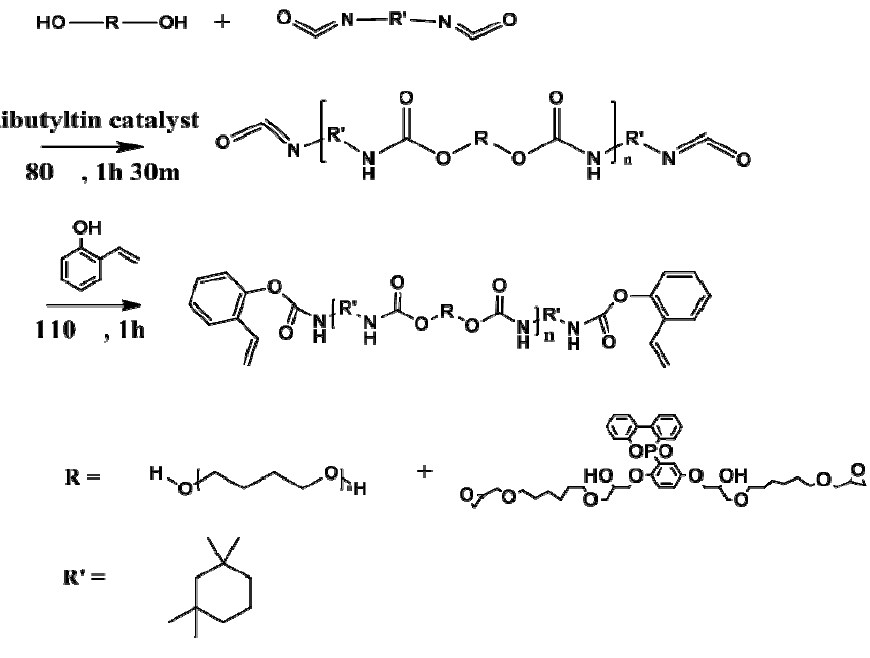
Figure 3. Reaction scheme for polyurethanes.